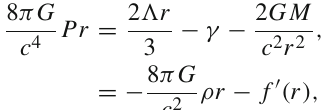
shown that this is generic for any negative value of σ . For sufficiently small η , the term − σ/ 2 η in Eq. (45) becomes dominant